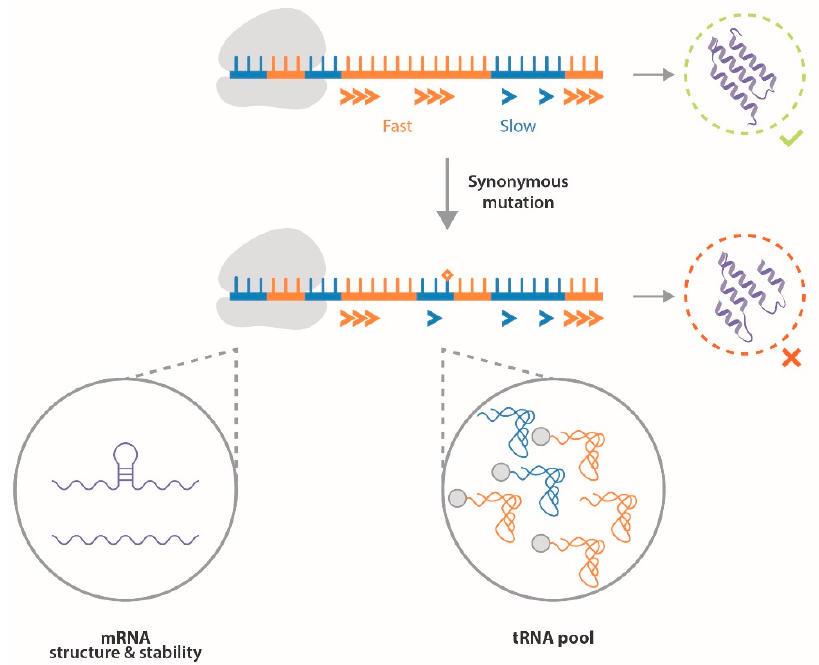
Figure 3. Synonymous mutations (represented by a star) can modify translational speed by impacting various parameters, such as the mRNA structure and the stability or availability of cognate tRNAs. This can ultimately result in the alteration of protein conformation, affecting its expression, stability and function.